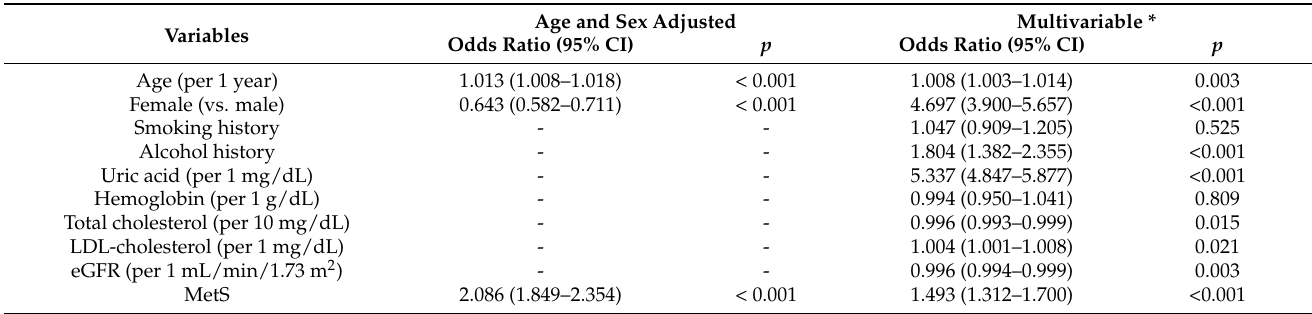
Table 2. Association of MetS and new-onset hyperuricemia using logistic regression